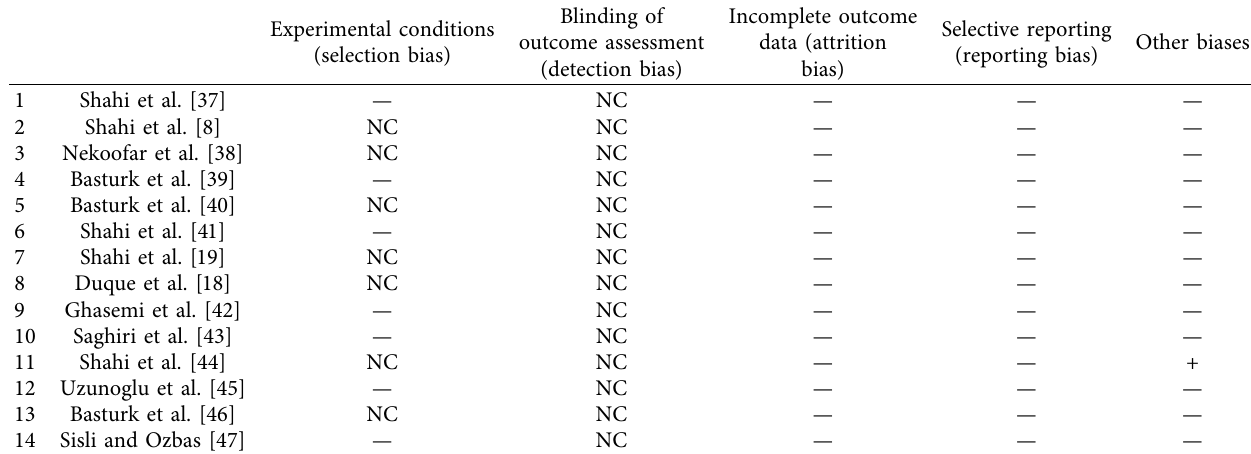
Table 2: Assessing the risk of bias in the included